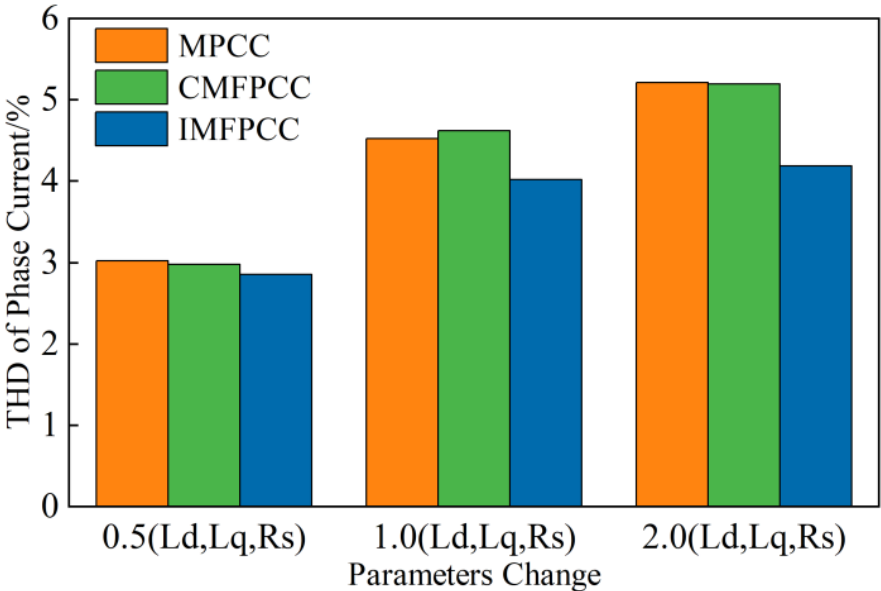
Figure 4. Comparison chart of phase current FFT analysis under parameters change.